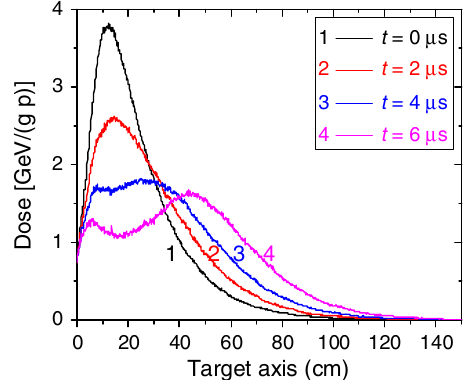
FIG. 3. Dose along the target axis for bunches delivered at different times t ¼ 0 , 2, 4, and 6 μ